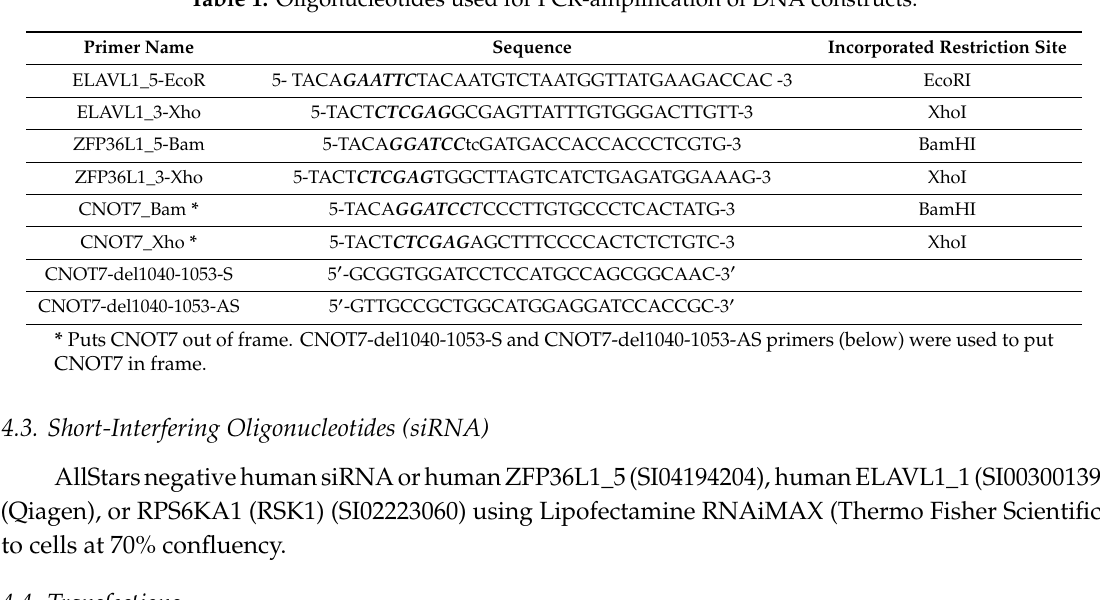
Table 1. Oligonucleotides used for PCR-amplification of DNA